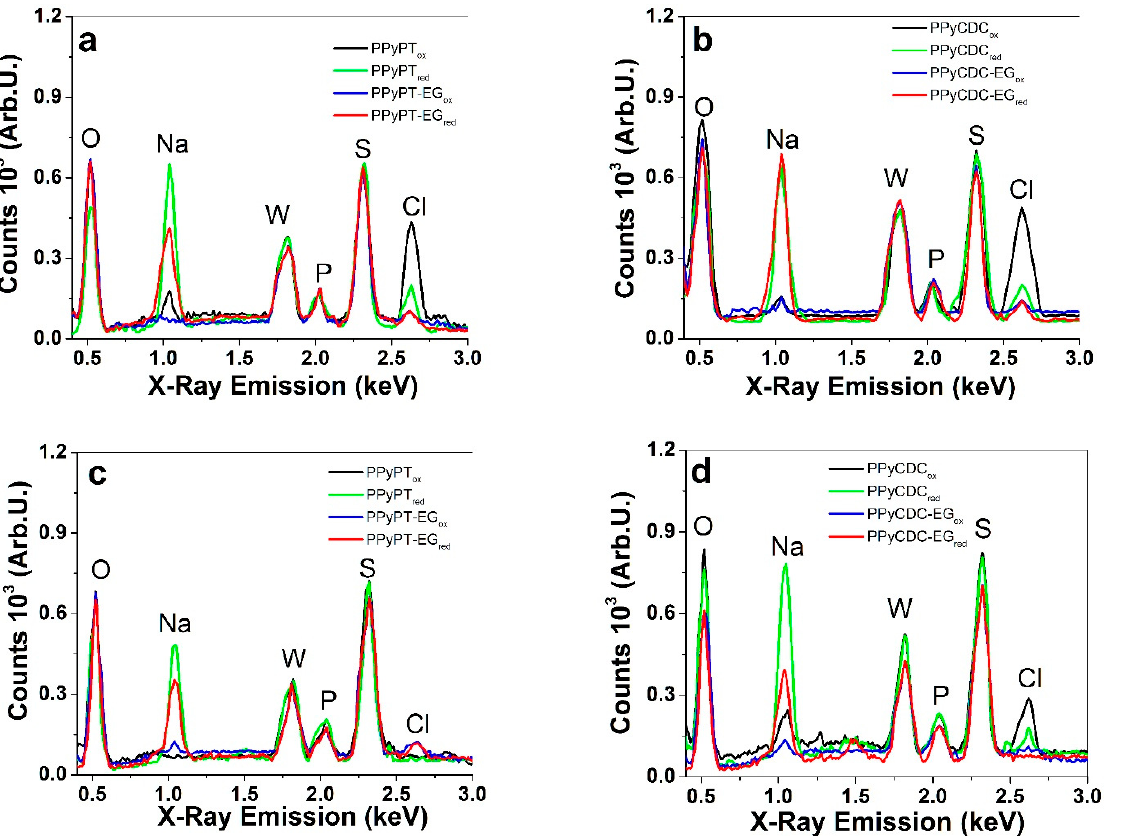
Figure 3. ( a ), EDX spectroscopy of cross-section images of PPy samples polymerized in EG:Milli-Q+ at oxidation such as PPyPT ox and PPyCDC ox (black line) and at reduction PPyPT red and PPyCDC red (green line) as well those PPy films polymerized in EG at oxidation with PPyPT-EG ox and PPyCDC-EG ox (blue line) and at reduction PPyPT-EG red and PPyCDC-EG red (red line), and in ( b ) PPy samples in NaClO 4 -PC and in ( c , d ), those in NaClO 4 -aq electrolytes.